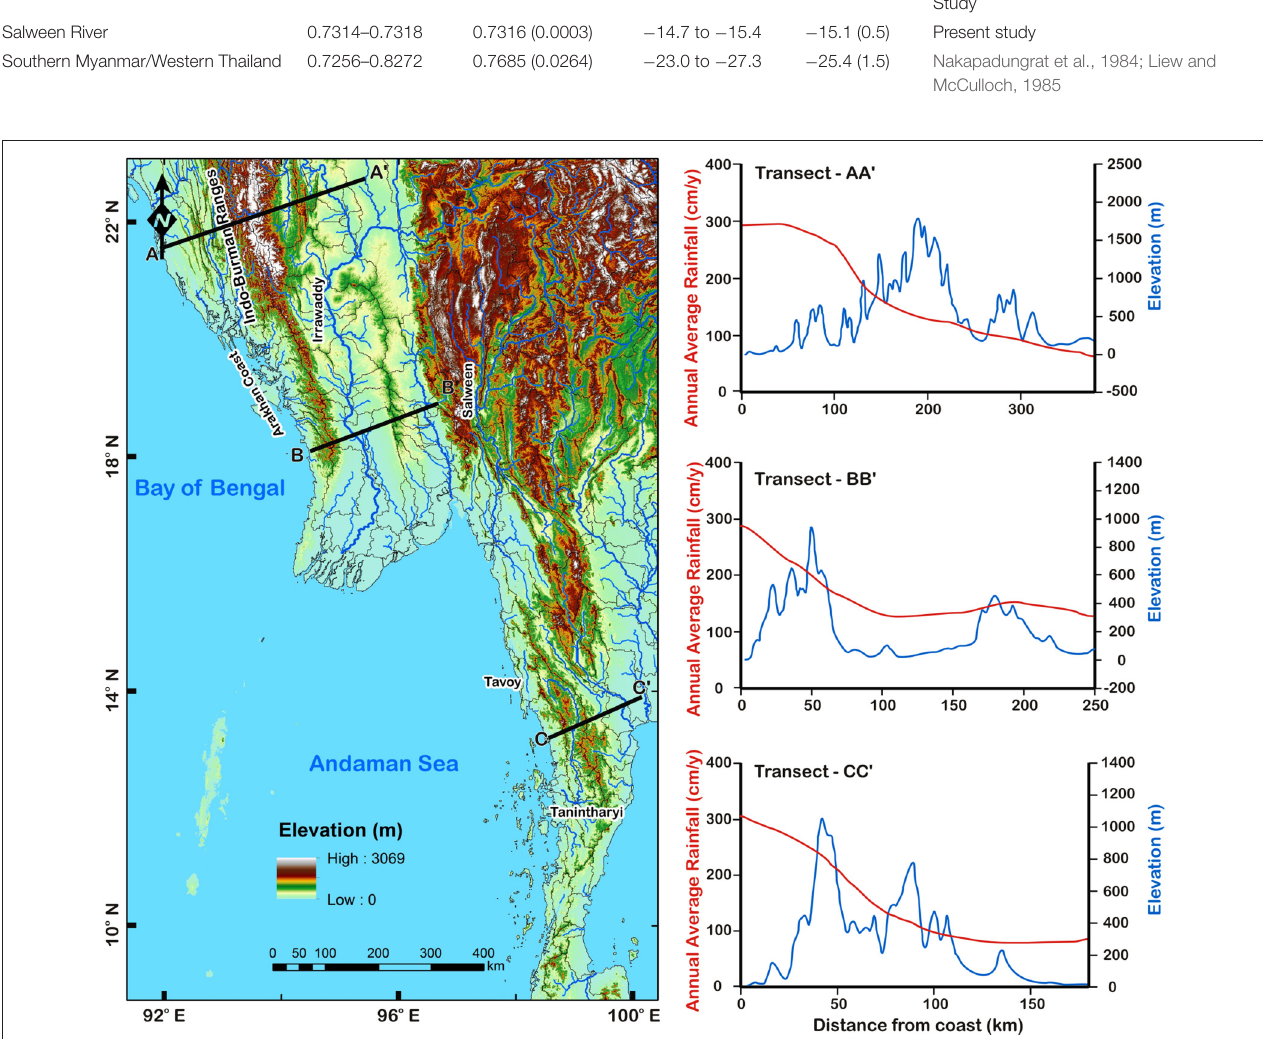
FIGURE 8 | Precipitation and elevation plotted along the three transects shown on DEM map following the SW monsoon track. Intense and focused precipitations over the higher relief of the western slopes of the IBA (Transects AA ′ , BB ′ ) and Western/Central granitic ranges (Transect CC ′ ) cause higher erosion in these catchment (Source: http://dwtkns.com/srtm/ and